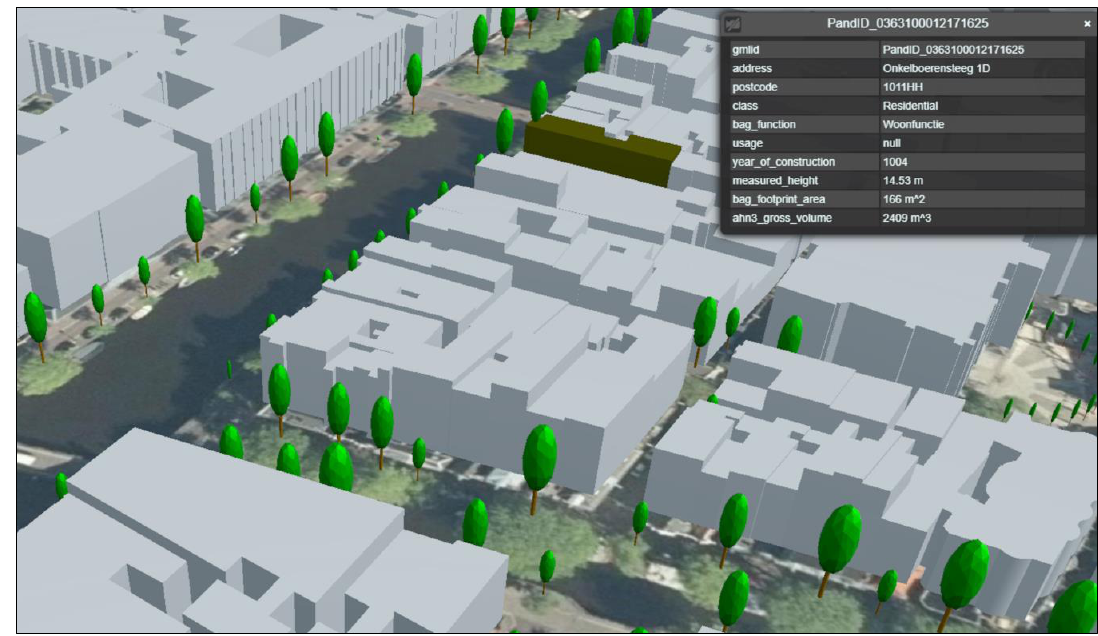
Figure 5. An excerpt of the generated 3D city model of Amsterdam.